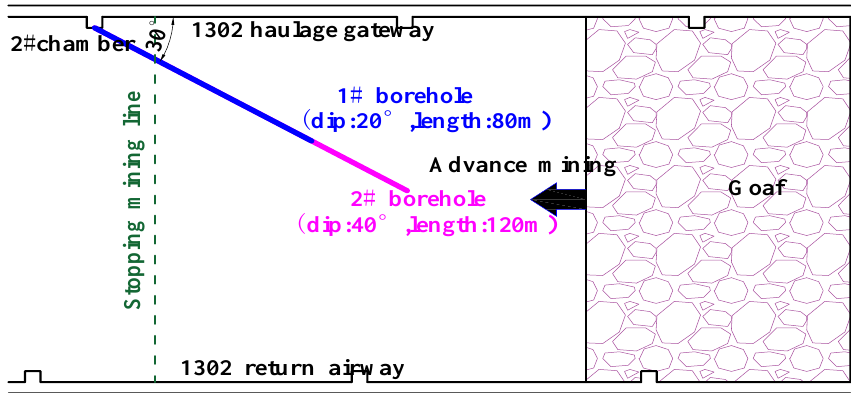
Figure 10. Location relationship of monitoring borehole and coalface.